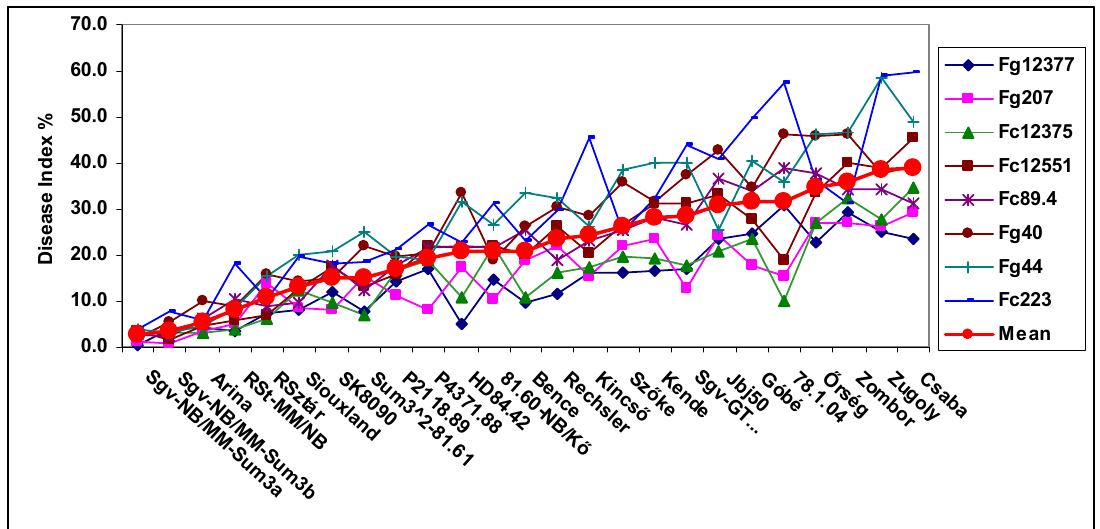
Figure 1. Resistance of winter wheat lines to F. graminearum and F. culmorum isolates 1994–1996. Disease index, [34]. Larger variations in surveying of the susceptible cultivars could suggest that the disease development is more variable in susceptible cultivars due to a mixture of factors including the genotypes. The most resistant ones have high stability and low variation.